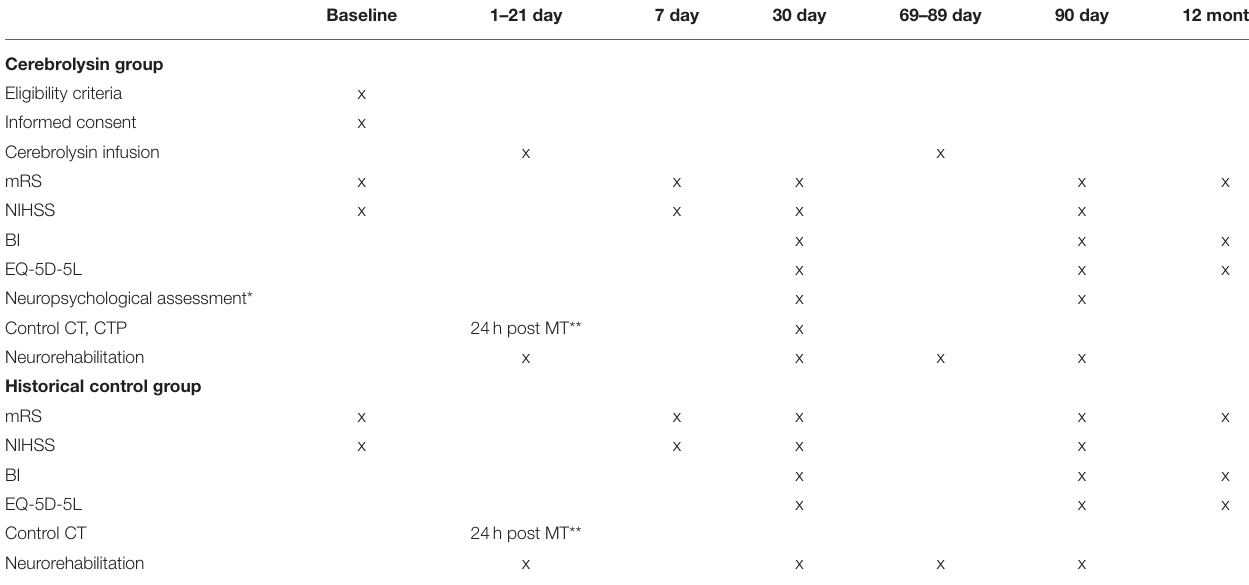
TABLE 3 | Study flow and eligibility